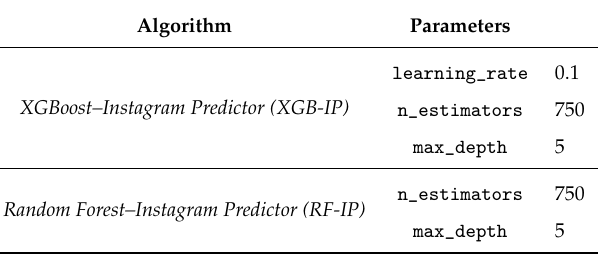
Table 3. Algorithm